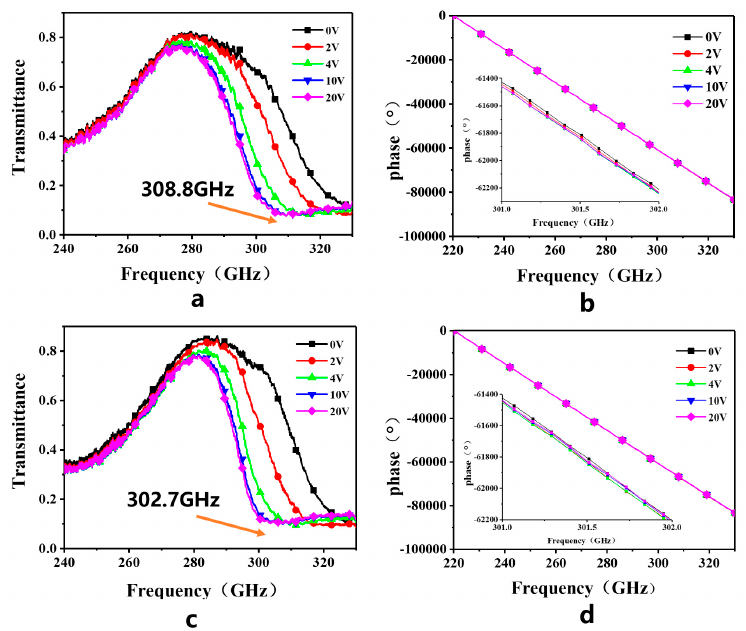
Figure 6. ( a ) LC S200 sample transmission spectra. ( b ) LC S200 sample phase information. ( c ) LC S200-2 sample transmission spectra. ( d ) LC S200-2 sample phase information. 2 sample transmission spectra. ( d ) LC S200-2 sample phase information. Table 3. Comparison of two LC samples (S200 and S200-2) at certain frequency points. Frequency